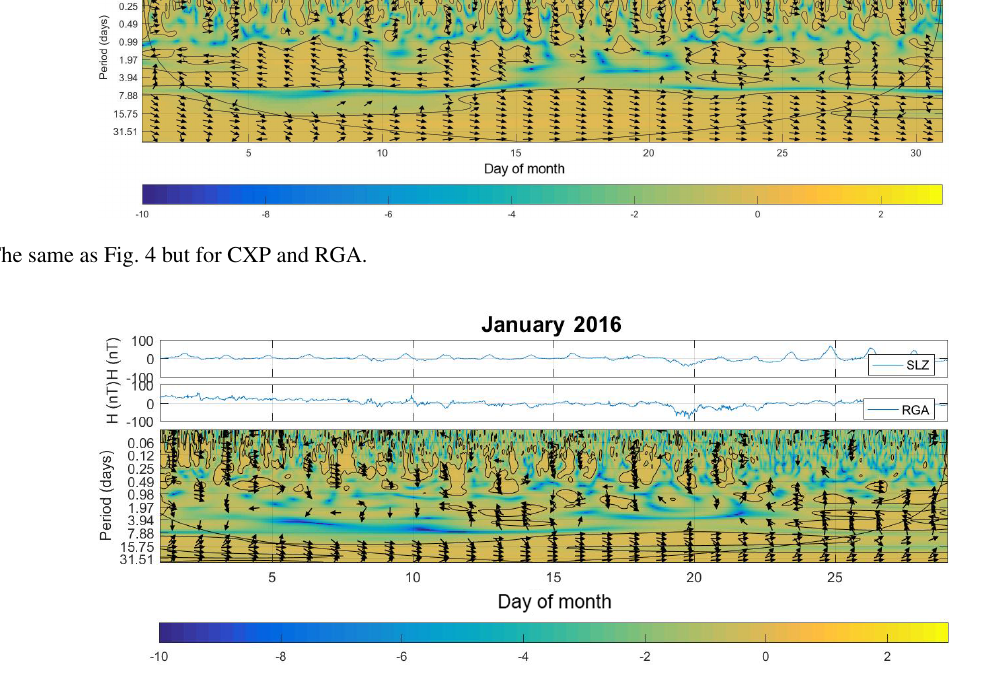
Figure 8. The same as Fig. 7 but for January